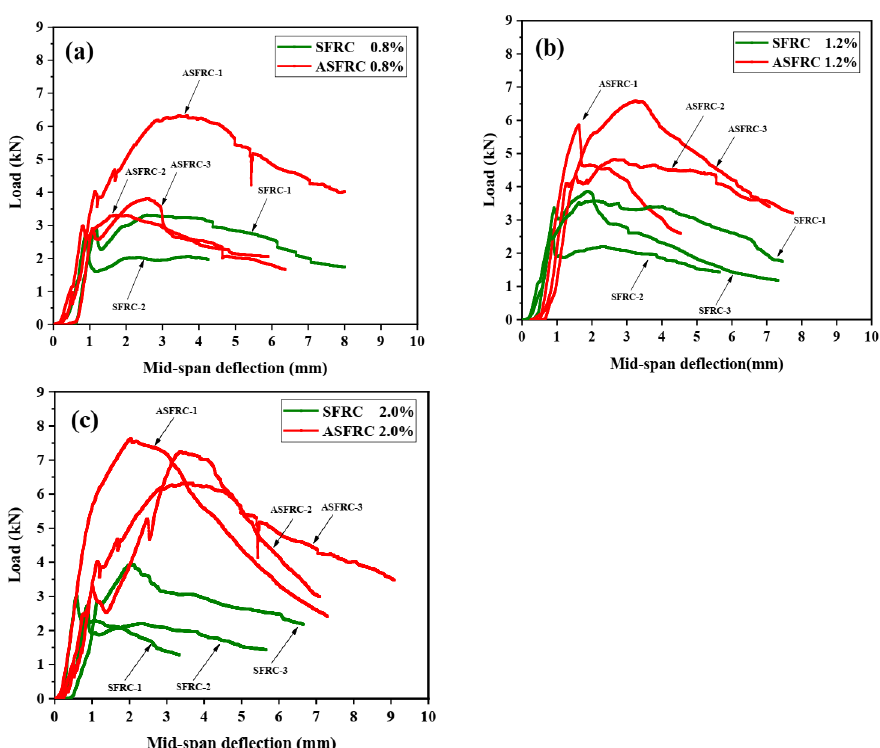
Figure 1. Comparison of load–mid span deflection curves for SFRC and ASFRC with different fiber volume fractions: ( a ) 0.8% of fiber volume fraction, ( b ) 1.2% of fiber volume fraction and ( c ) 2.0% of fiber volume